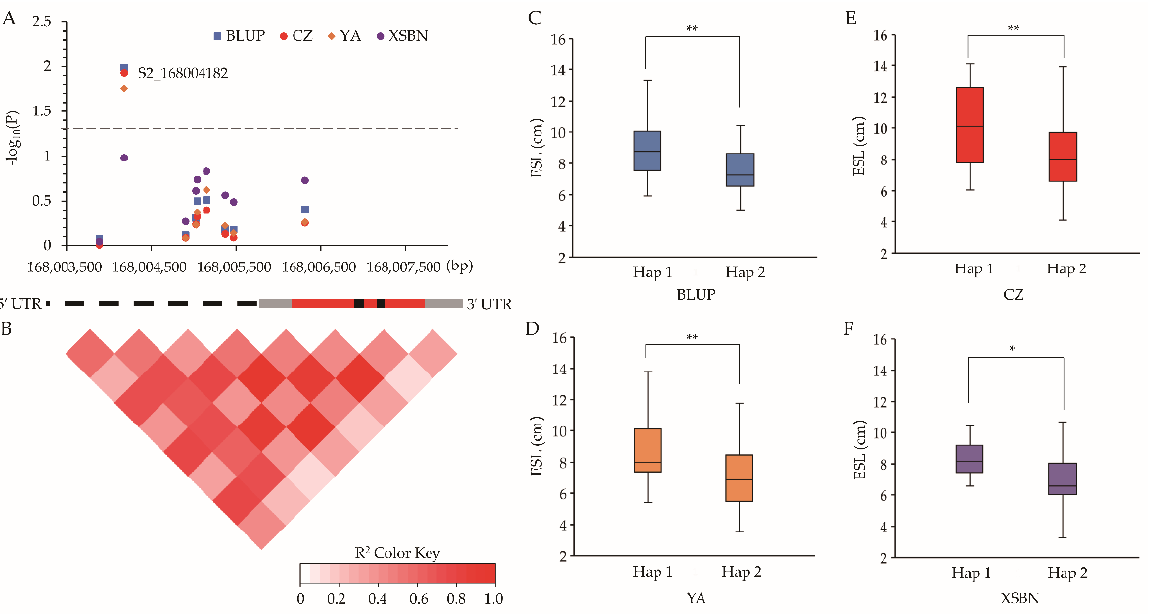
Figure 4. Results of Zm00001d005293 -based association analysis ( A ) Association analysis of Zm00001d005293 . The dashed line showed the significance threshold of p = 0.05 for detecting the associations. Schematic of the Zm00001d005293 gene structure is shown in the bottom. ( B ) Pairwise linkage disequilibriums between markers. ( C – F ) Comparison of ESL between different haplotypes in BLUP ( C ), YA ( D ), CZ ( E ), and XSBN ( F ). CZ, YA, and XSBN represent the environments Chongzhou, Ya’an, and Xishuangbanna, respectively. BLUP denotes best linear unbiased prediction. Hap1, haplotype 1; Hap2, haplotype 2. * Significant at p = 0.05 level, ** Significant at p = 0.01 level.